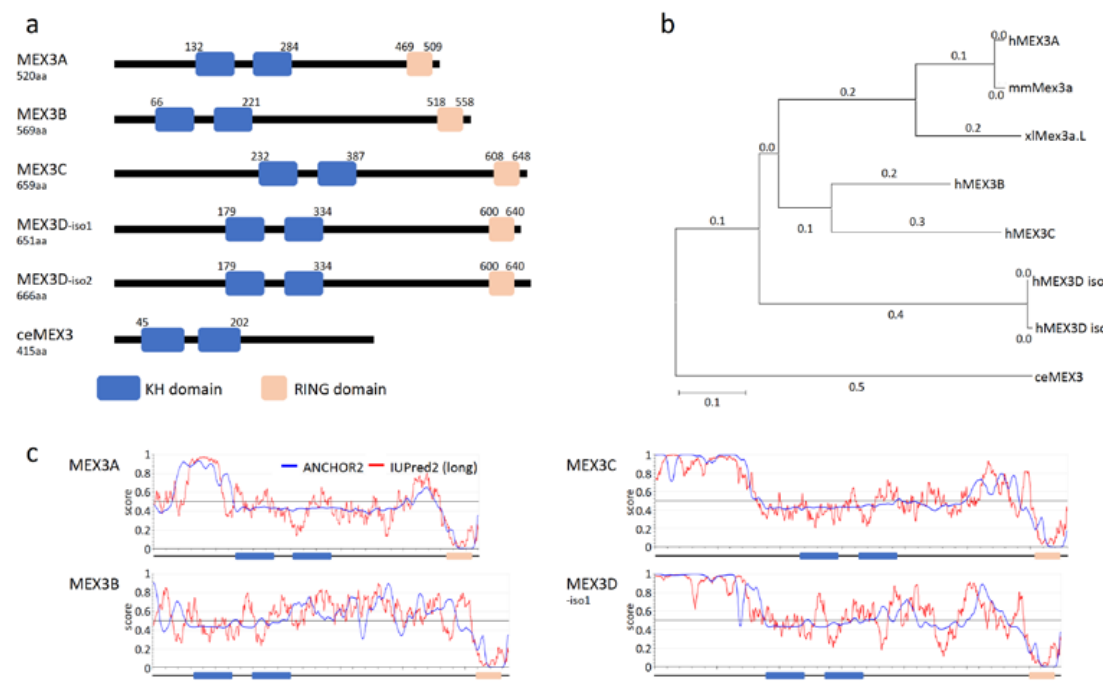
Figure 1. MEX3 family of RNA-binding proteins. ( a ) Domain structure of human MEX3 proteins and the founder ortholog ceMEX3 of Caenorhabditis elegans with RNA-binding domains (HNRNPK homology domains; KH; blue) and the really interesting new gene (RING domain; orange). Proteins shown: MEX3A (Acc. No. NM001093725.2), MEX3B (Acc. No. NM032246.6), MEX3C (Acc. No. NM016626.5), MEX3D-isoform1 (Acc. No. NM203304.4), MEX3D-isoform2 (Acc. No. NM001174118.2) and MEX3 (Acc. No. NM001381229.2). Annotation and localization of KH di- and RING domain according distinct MEX3 paralogs from different species (h: human, mm: Mus musculus , xl: Xenopus laevis and ce: Caenorhabditis elegans ). Protein sequences were aligned using Tcoffee before creating a phylogenetic tree with MEGA X. ( c ) Prediction of intrinsically disordered regions (IUPred2; red) and disordered protein-binding regions (ANCHOR2; blue) using